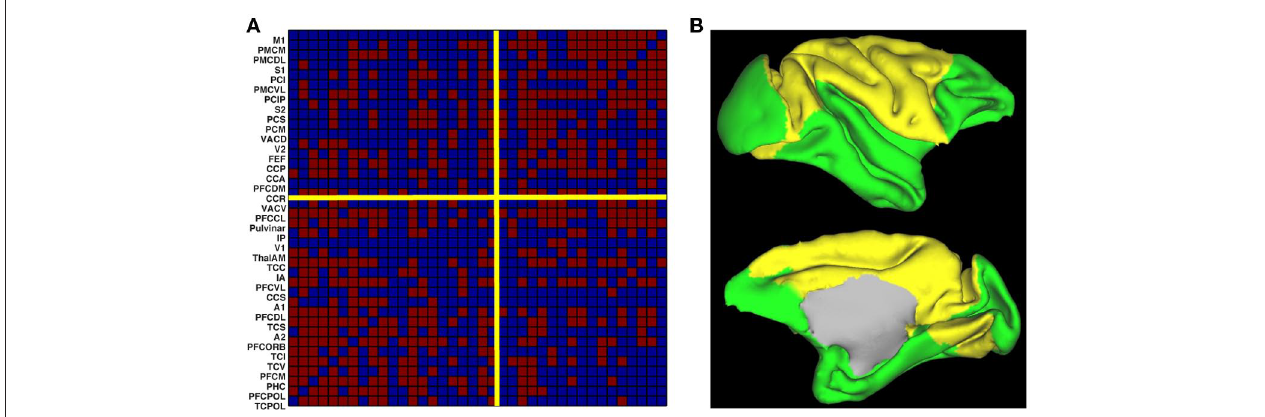
Figure 1 | Structure of the large-scale model of the macaque brain. (A) Structural connectivity matrix (existing connections in red) between the 33 regions of the CoCoMac database. The network is separated in two communities (yellow separation lines). (B) Cortical surface representation of the two communities (yellow and green). Figure adapted from Deco et al. (2009).